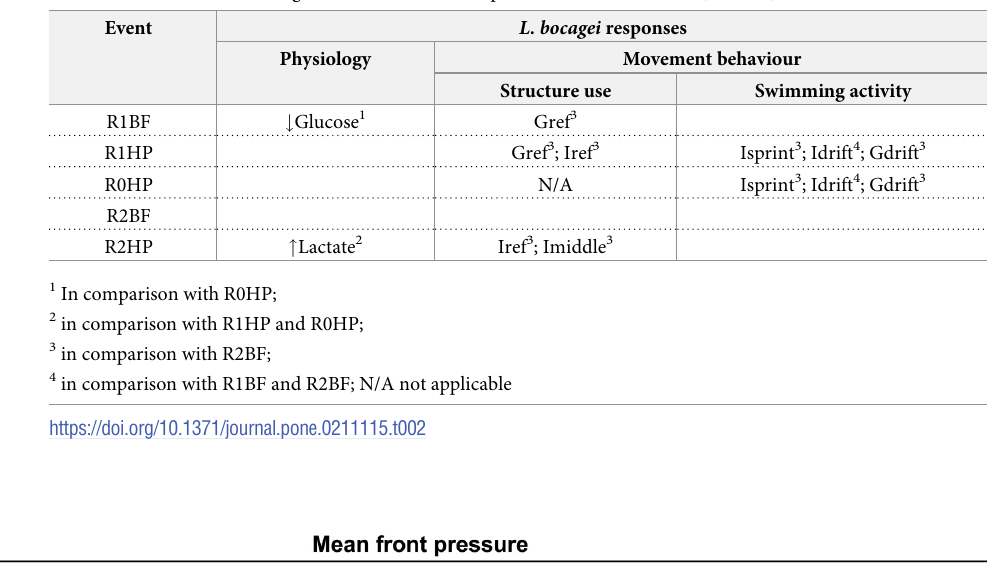
PLOS ONE | https://doi.org/10.1371/journal.pone.0211115 January 23,